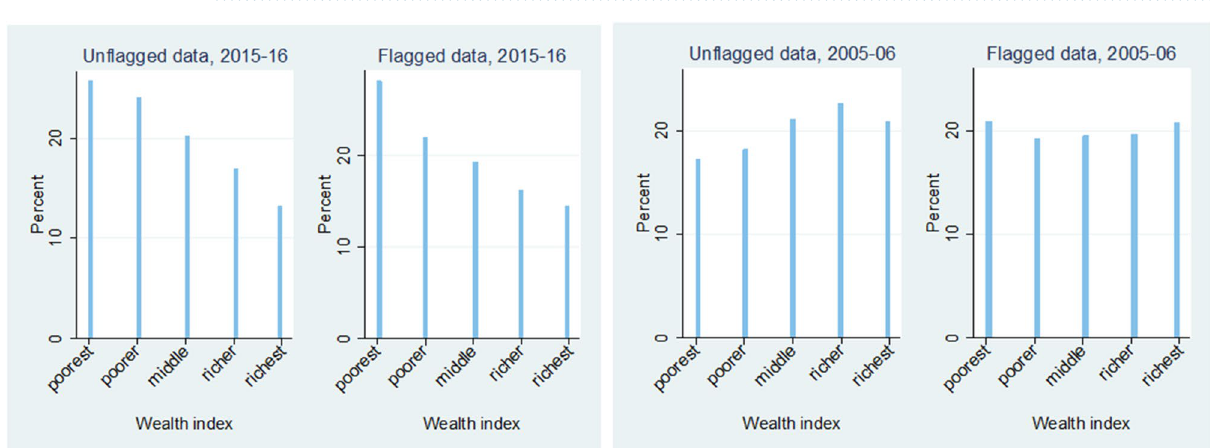
Figure 6. Differences in distribution of wealth indices for flagged and unflagged data.